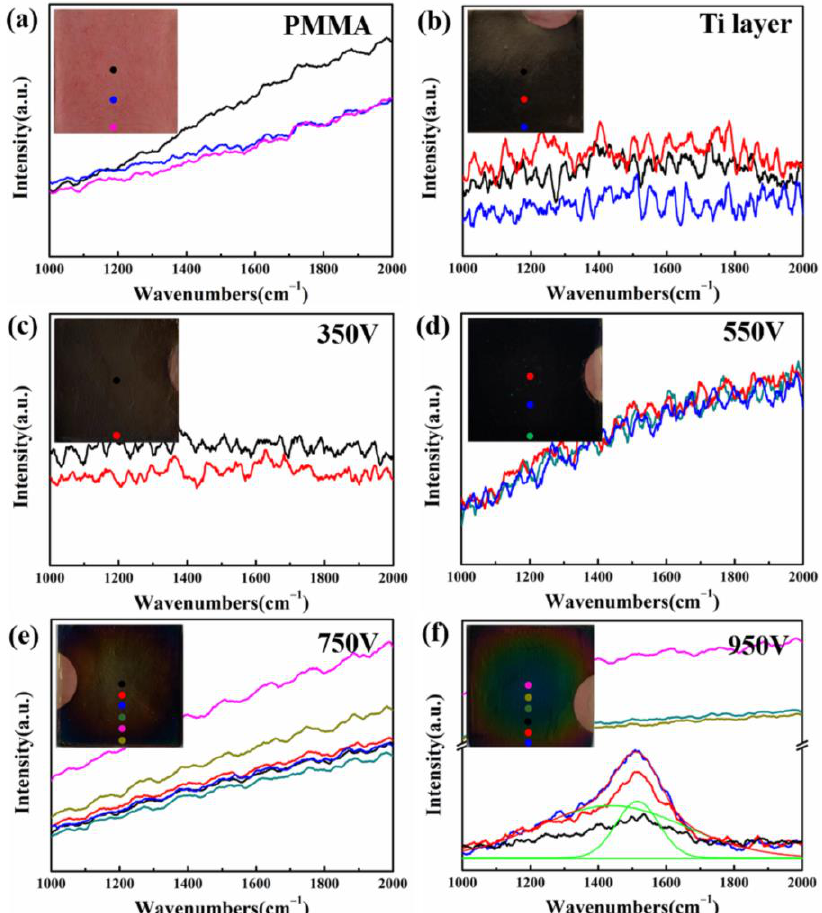
Figure 2. Raman spectra measured at different positions of ( a ) PMMA, ( b ) Ti/PMMA and the films prepared on Ti/PMMA at different substrate bias of ( c ) 350 V, ( d ) 550 V, ( e ) 750 V, and ( f ) 950 V without conductive material. The color of the Raman curve represents the results measured at the corresponding color position in the illustration.